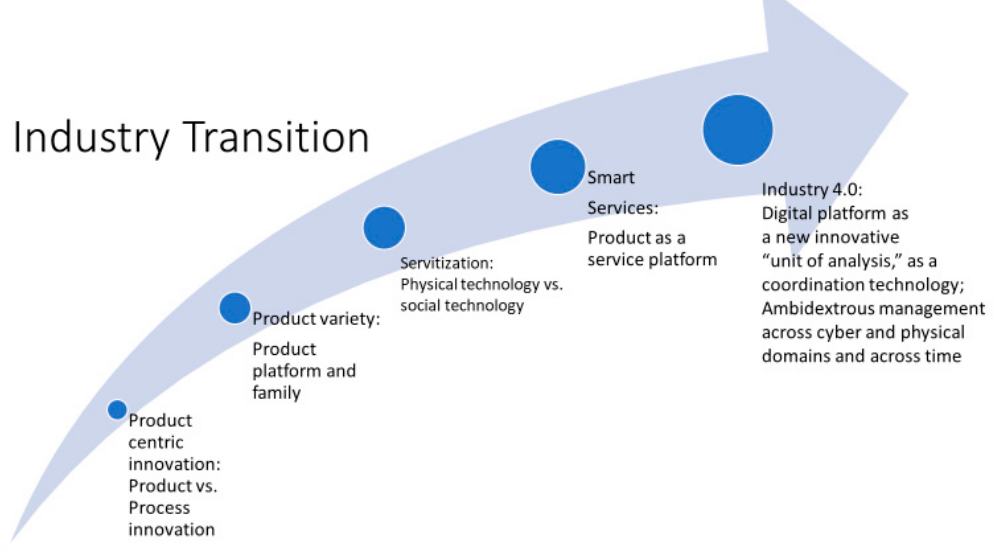
ff erent stages of industry